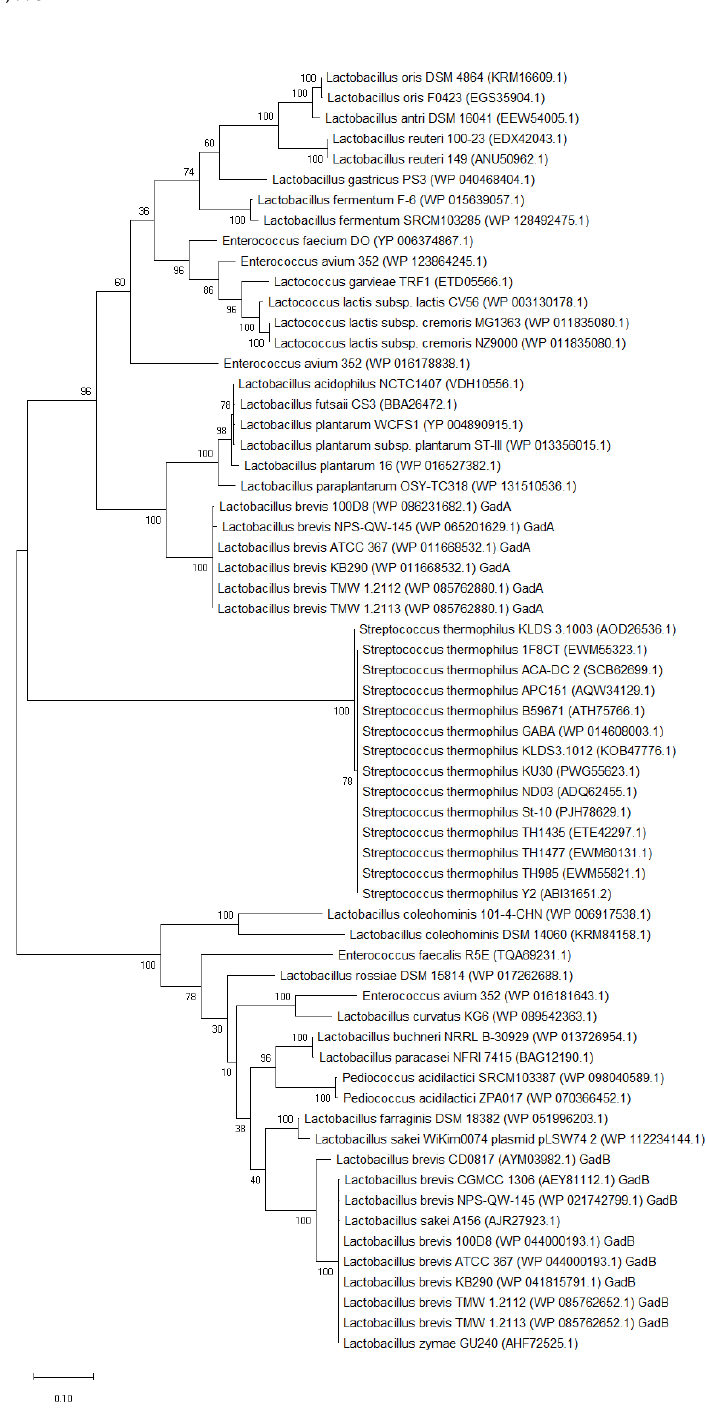
Figure 3. Phylogenetic tree (maximum-likelihood method) based on amino acid sequences of GAD from LAB. Figure was generated from MEGA (version X 10.1) after ClustalW alignment of GADs. The GenBank accession number of GAD is indicated in the braces.